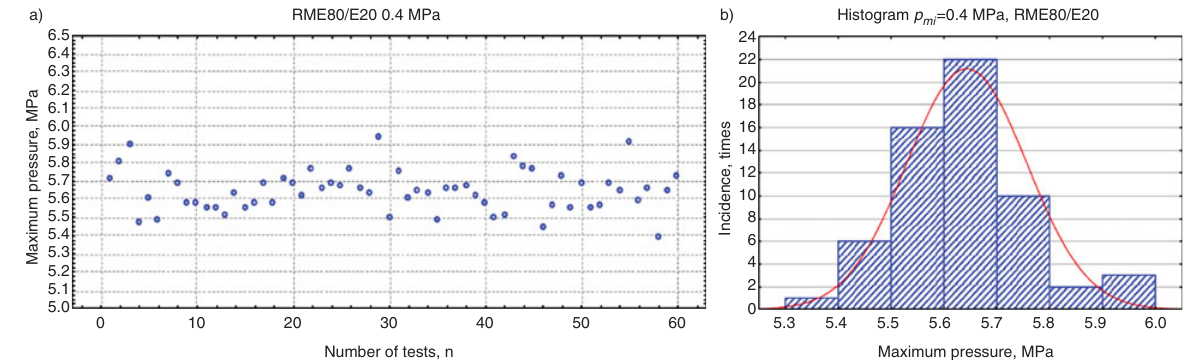
Fig. 8. Statistical analysis of cyclic instability of engine working on RME80/E20